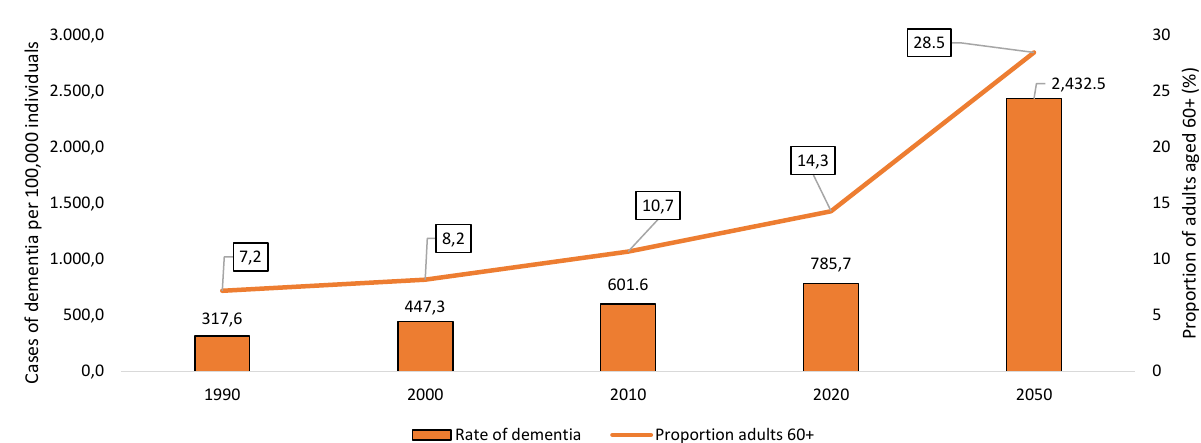
Figure 1. Rate of dementia per 100,000 individuals and proportion of older adults aged 60 years or older in Brazil from 1990 to